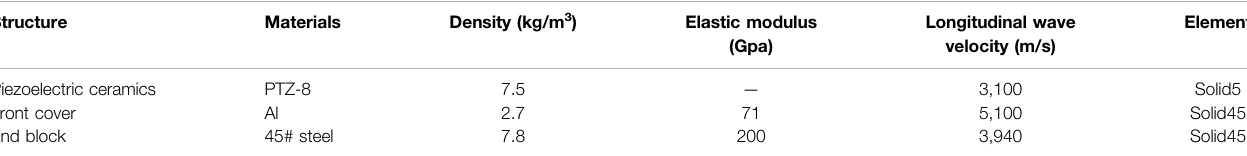
TABLE 3 | Material properties of piezoelectric vibrator. Structure